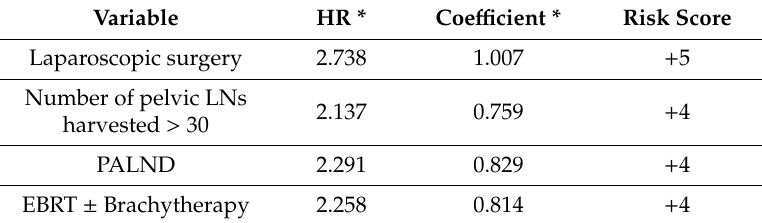
Table 3. Coe ffi cient of risk factors and lower extremity lymphedema risk